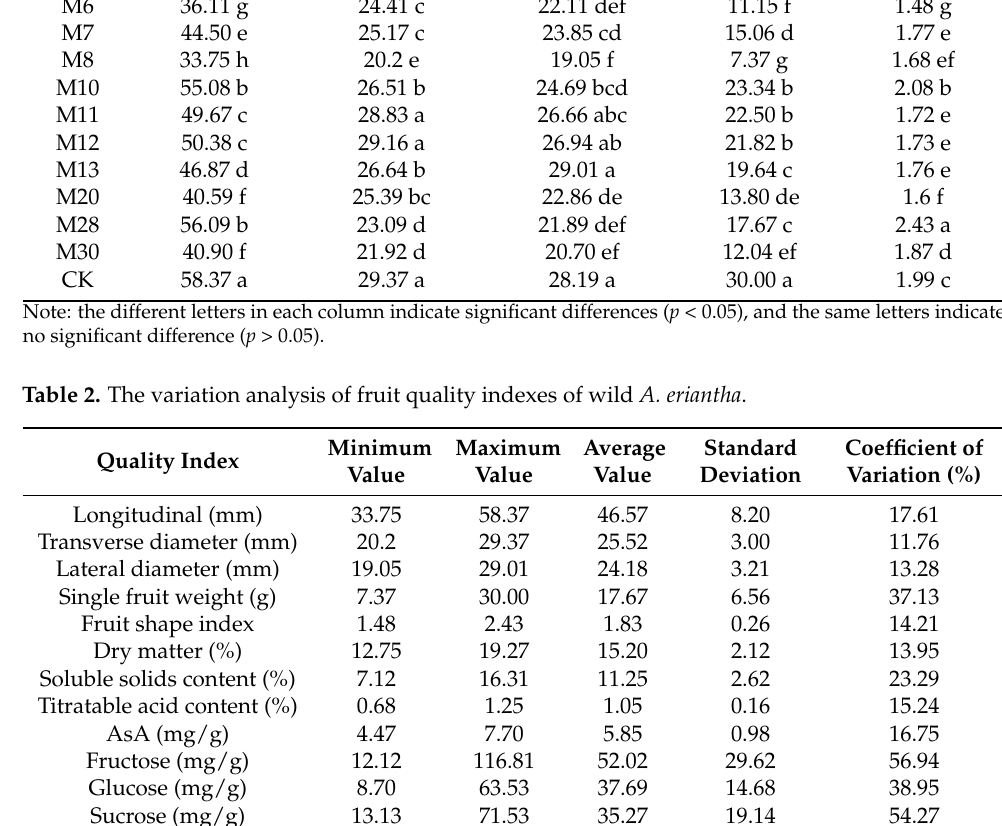
Table 1. Fruit appearance quality indexes of wild A. eriantha of different varieties (lines). Variety